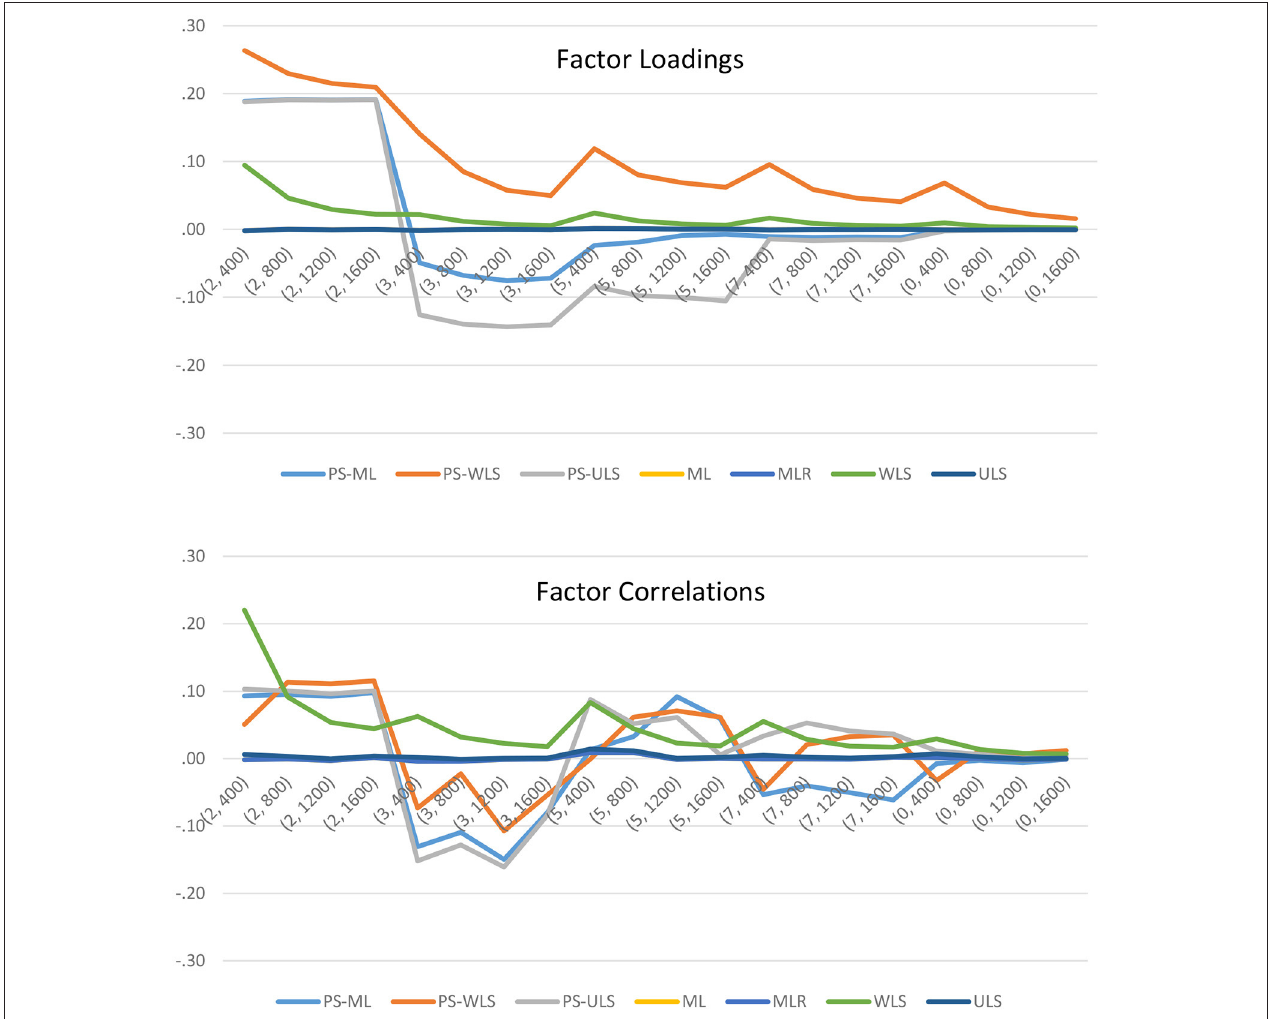
FIGURE 3 | Biases of the factor loadings and factor correlations when data are linearly related. The horizontal axis shows the 20 simulation conditions, where the first number of the bracket indicates the scale of measurement (i.e., 2 number refers to the sample